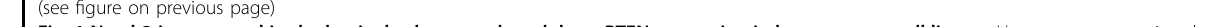
Fig. 1 Notch3 is expressed in the luminal subtype and modulates PTEN expression in breast cancer cell lines. a Heat-map representing the correlation of the mRNA of PTEN, Notch3, and some other genes obtained from Weigelt Breast dataset based on the analyses of about 10,335 genes in ONCOMINE. There was a positive correlation between the mRNA level of Notch3 and PETN, the correlation coef fi cient r = 0.781, P < 0.05 ( b ) Notch3 and PTEN expression in distinct subtype of breast cancer cell lines detected by western blotting. c , d Relative Notch3 and PTEN mRNA levels in breast cancer cell lines quanti fi ed by real-time PCR. e The immuno fl uorescence staining of PTEN and Notch3 in MCF-7 and T-47D cells. Nuclei were counterstained with DAPI. f , g The levels of Notch3 and PTEN protein and mRNA in MCF-7 cells were detected by western blotting or real-time PCR, respectively, following Notch3 knockdown by siRNA. f , h Notch3 and PTEN protein and mRNA expression levels in MDA-MB-231 cells were measured by western blotting or real-time PCR, respectively, following expression of pCLE-N3ICD. i , j The levels of Notch3 and PTEN protein and mRNA in MCF-7 cells were detected by western blotting or real-time PCR, respectively, following PTEN knockdown by siRNA. i , k The levels of Notch3 and PTEN protein and mRNA in MDA-MB-231 cells were detected by western blotting or real-time PCR, respectively, following ectopic expression of PTEN in MDA-MB-231 cells. The experiments were repeated three times. The scale bar represents 50 μ m. * P < 0.05, ** P < 0.01, *** P < 0.001, **** P <